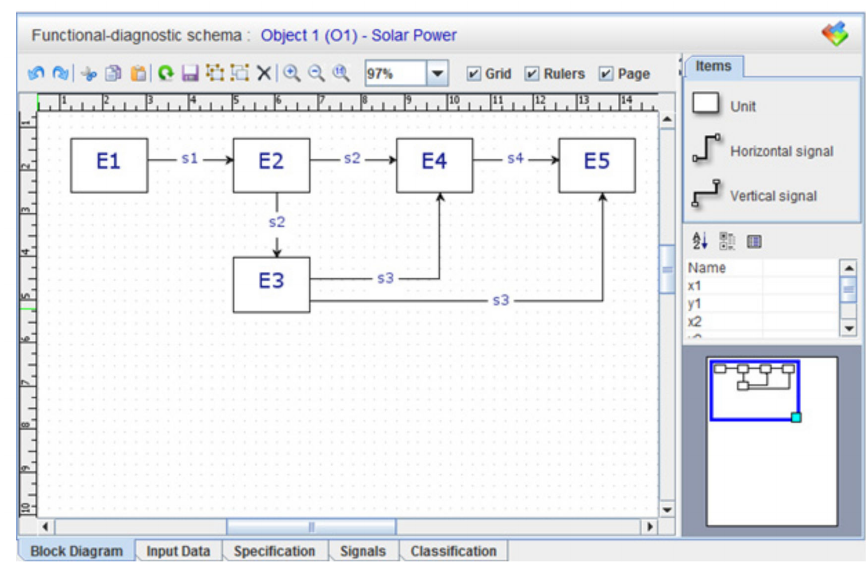
Figure 7. Result form of DIAG 2 program for “Structure” module.